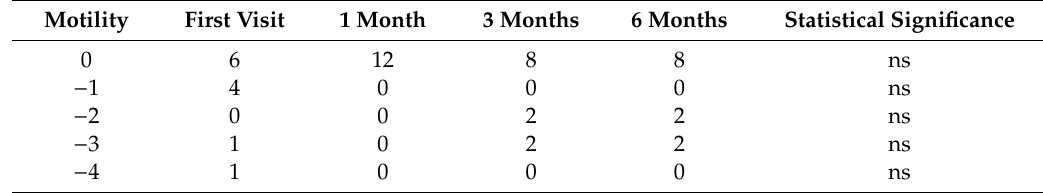
Table 2. Vertical and horizontal five-point scale (0 to − 4) for 12 patients treated with ear cartilage. Table 1. Vertical and horizontal five-point scale (0 to − 4) for 72 titanium meshes.